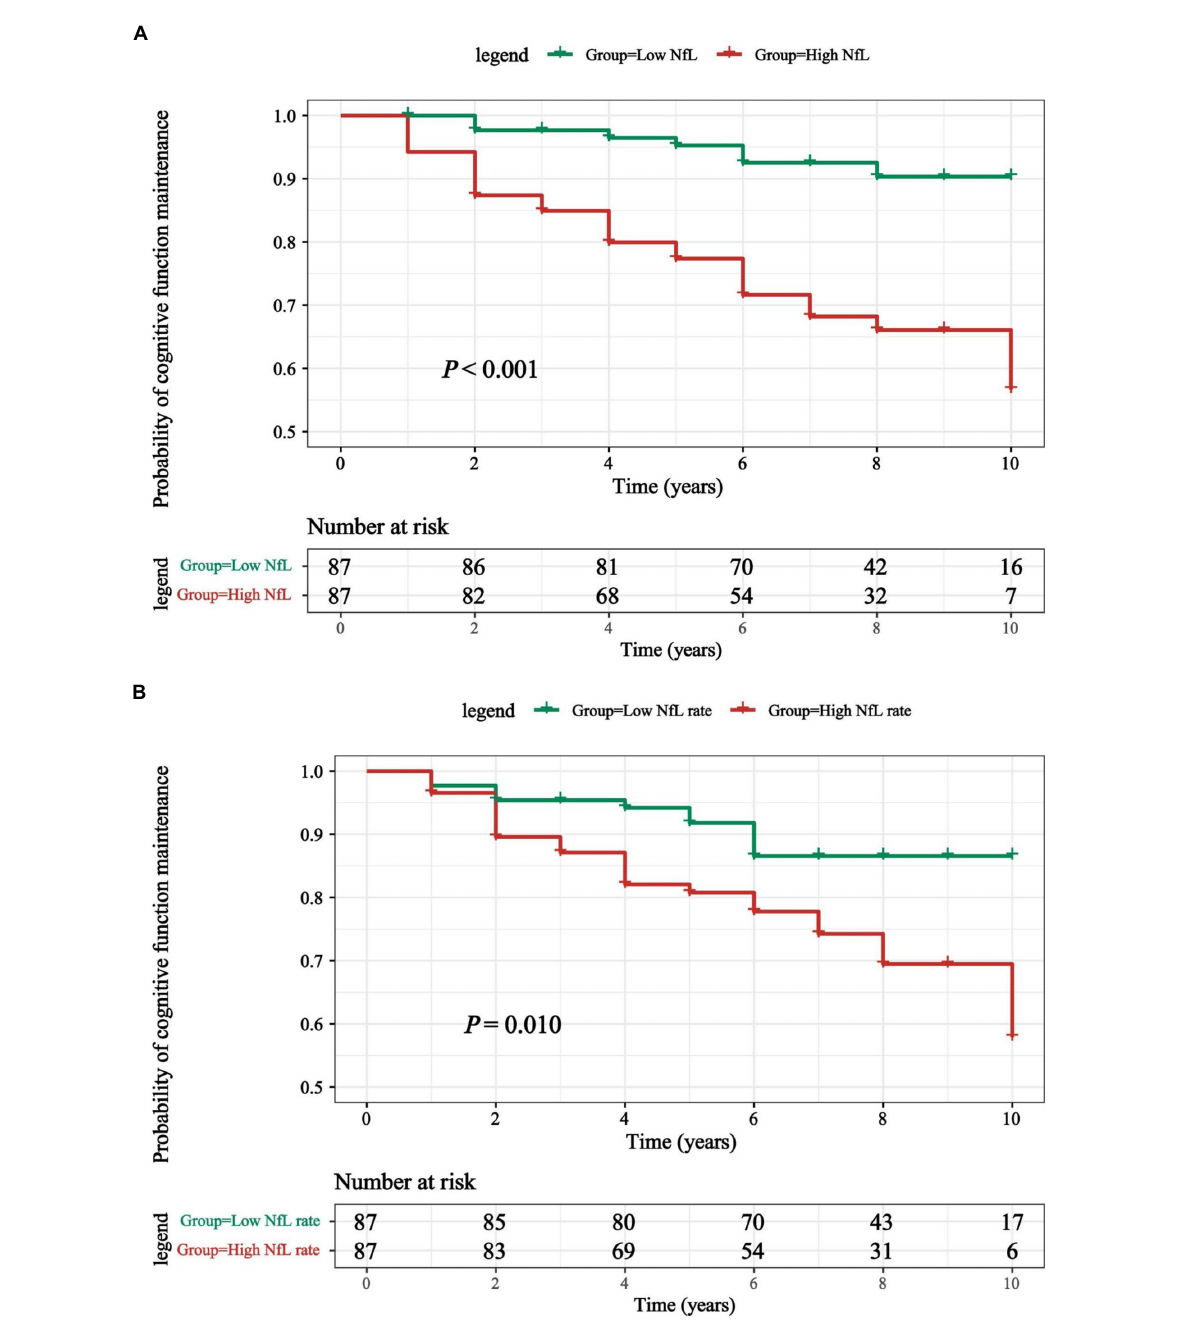
FIGURE 3 (A) Kaplan-Meier curves were used to compare the cumulative probability risk of cognitive progression in the follow-up among participants which were divided into 2 groups by the median of CSF NfL levels. (B) Kaplan-Meier curves were used to compare the cumulative probability risk of cognitive progression in the follow-up among participants which were divided into 2 groups by the median of CSF NfL change rate. Kaplan–Meier curve for conversion from de novo PD patients converted to PD-D during 9-years follow-up. PD, Parkinson’s disease; PD-D, Parkinson’s disease with dementia; NfL, neurofilament